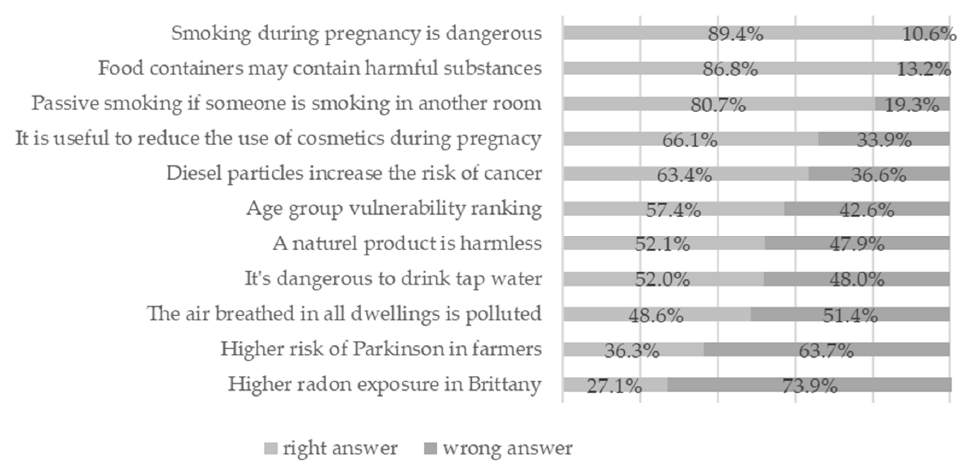
Figure 2. Details of answers to the knowledge questionnaire.